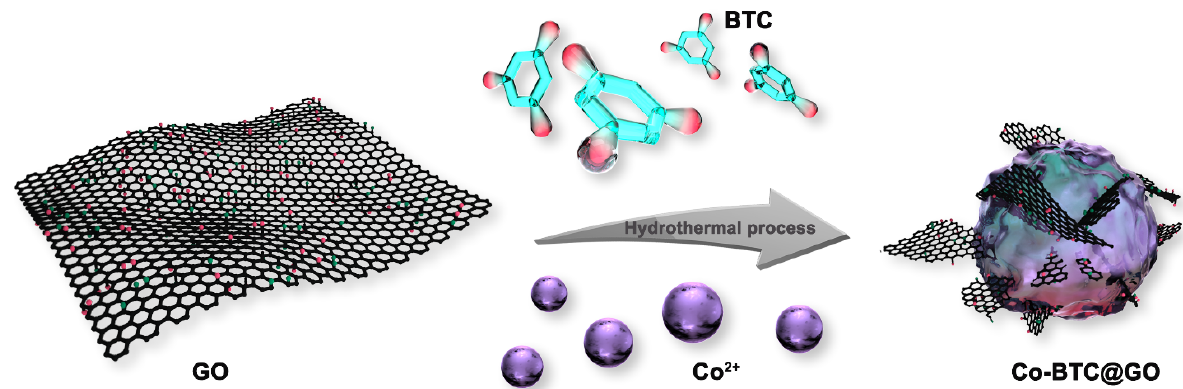
Figure 1. The preparation process of the Co-BTC@GO